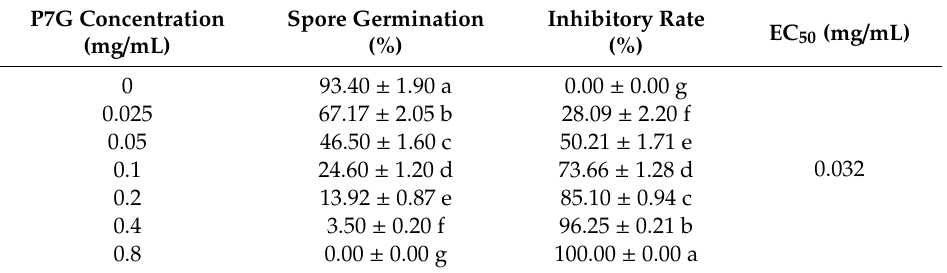
Table 2. Inhibitory e ff ect of P7G on spore germination of P. italicum . P7G